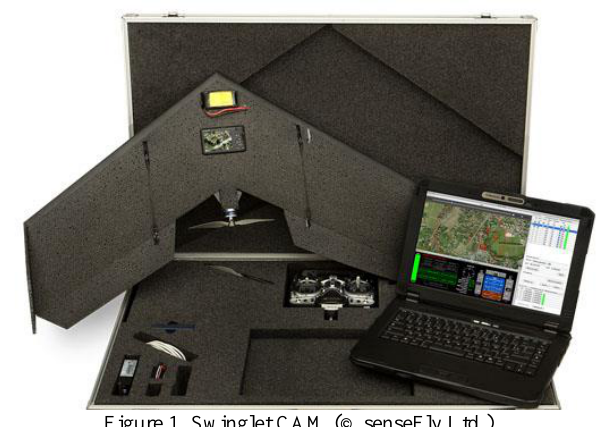
Figure 1. Swinglet CAM (© senseFly